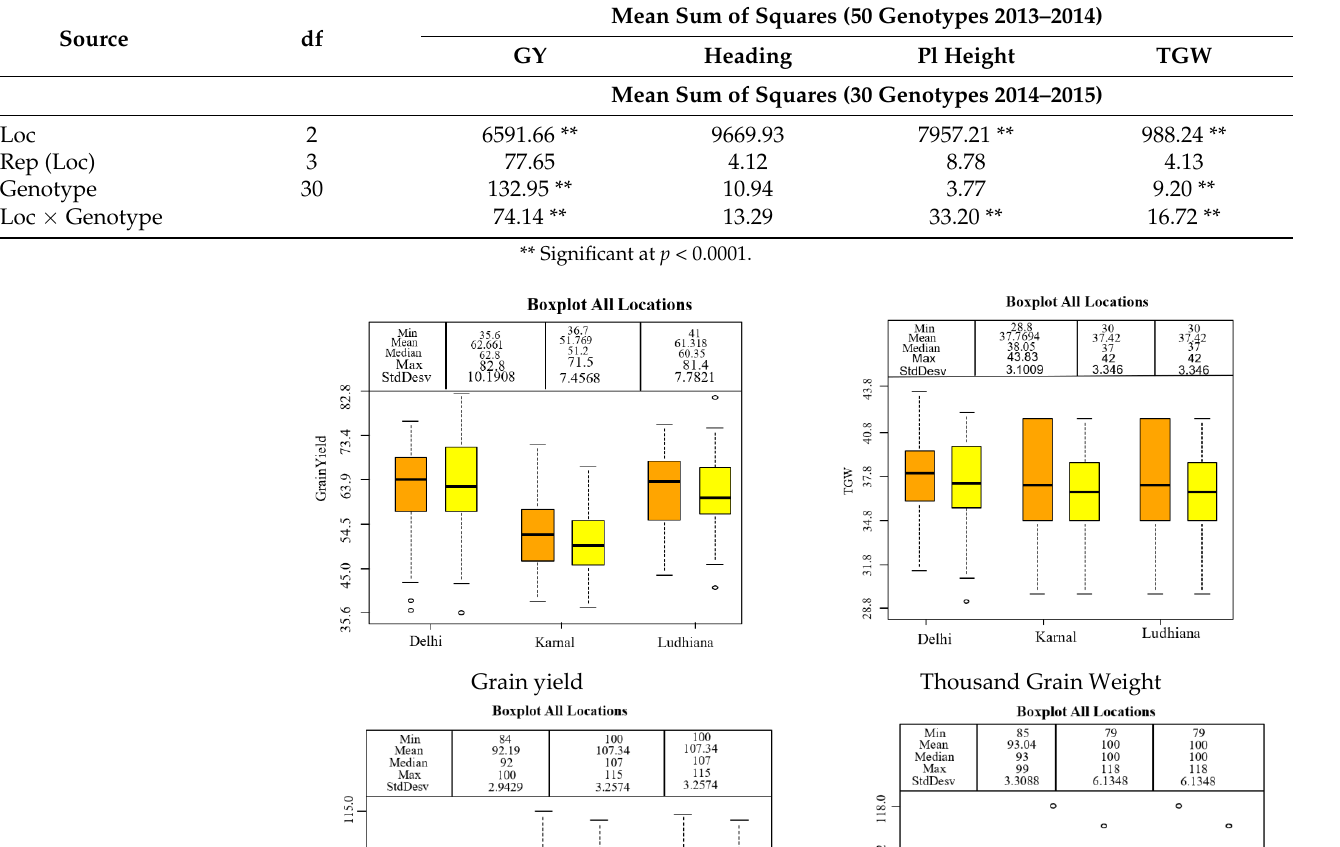
Table 3. Analysis of variance of grain yield and yield traits of wheat genotypes when evaluated under three locations of